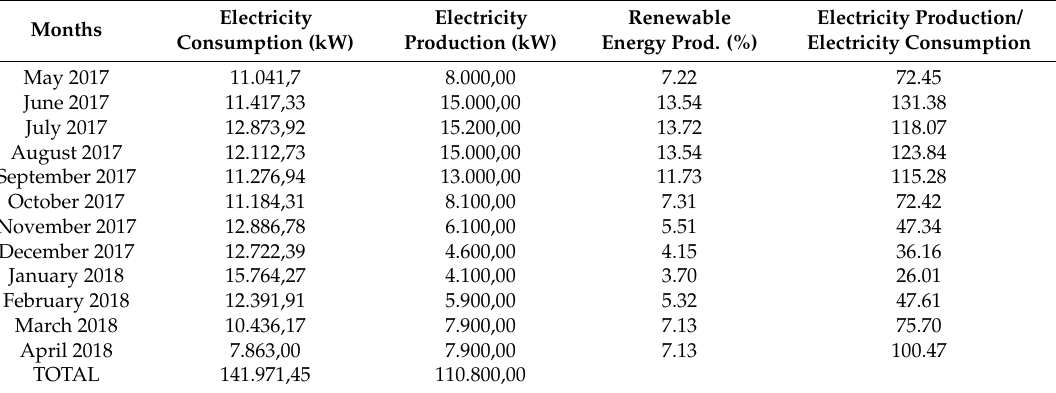
Table 6. The annual electricity consumption and production values of Konya Unilever Vector Admin Building. Electricity Electricity Renewable Months Consumption (kW) Production (kW) Energy Prod.